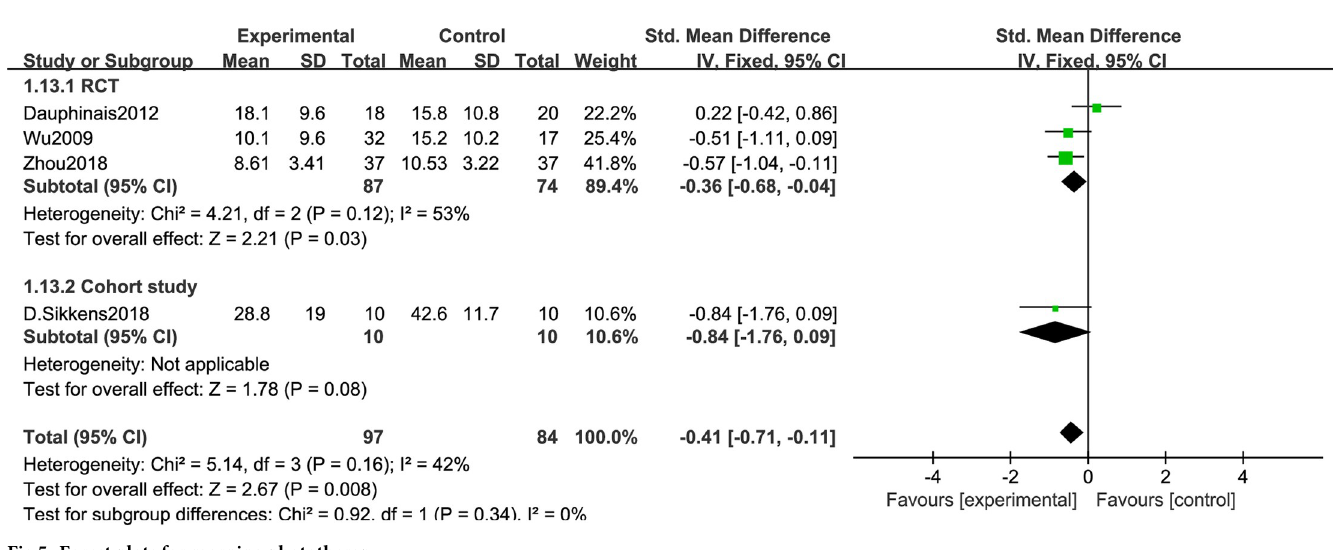
Fig 5. Forest plots for morning